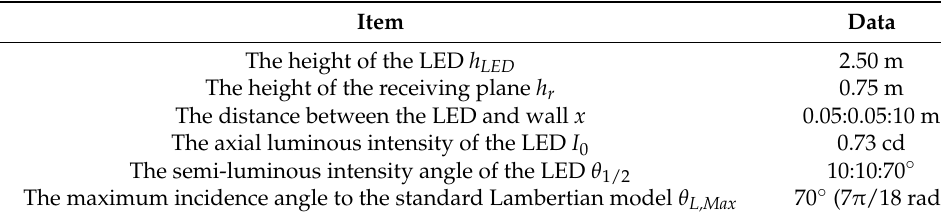
Table 1. Calculation setting data table.